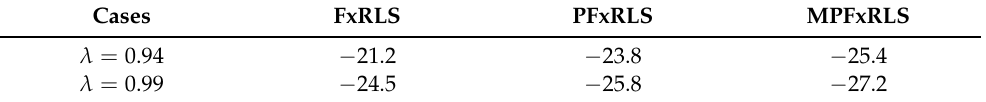
Figure 8. De-noising result for small forgetting factor λ = 0.96: ( a ) shows the result of residual error. ( b ) shows the result of NMSE. Table 5. Steady-state NMSE of FxRLS, PFxRLS and MPFxRS in the real-time experiment